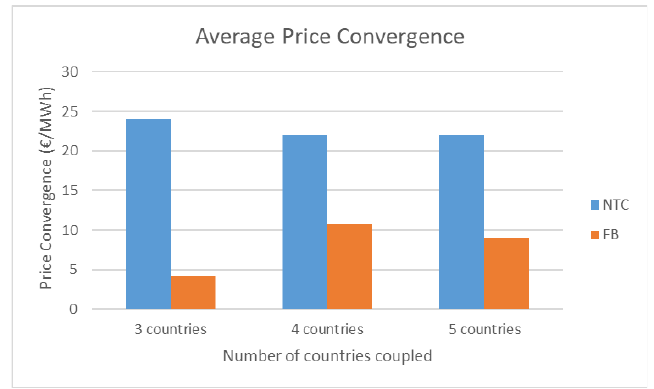
Figure 9. Average price converge index via both approaches.